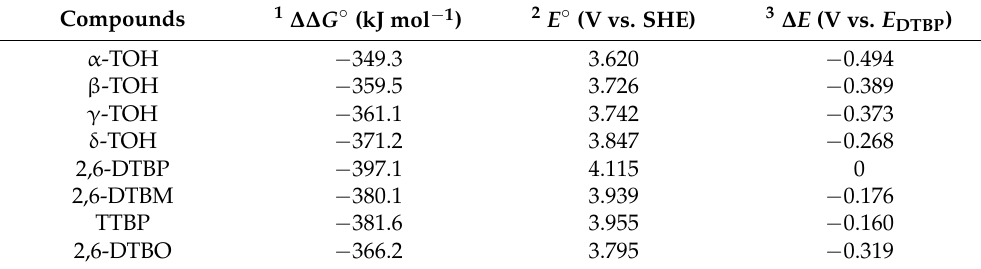
Table 2. Standard redox potentials ( E ◦ , V vs. SHE) of PhO • /PhO − of the compounds and ∆ E (V